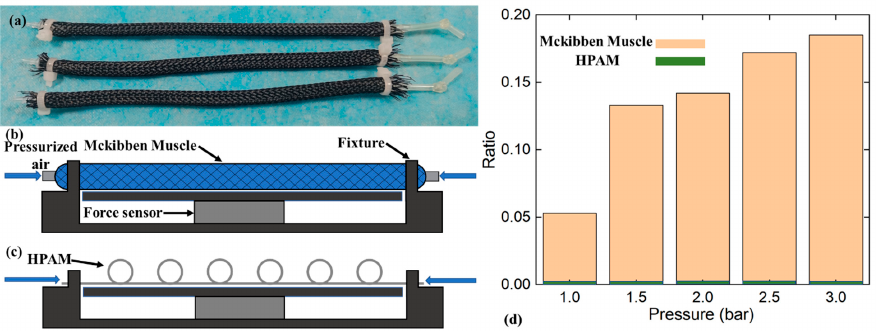
Figure 8. ( a ) Three Mckibben muscles with an outer and inner diameter of 5 mm and 2 mm, respectively, ( b ) Mckibben muscles are fixed on a test bench to obtain extra squeezing force, ( c ) HPAM is fixed on a test bench to obtain extra squeezing force, ( d ) the plot of extra squeezing force to output force ratio changing with pressure.